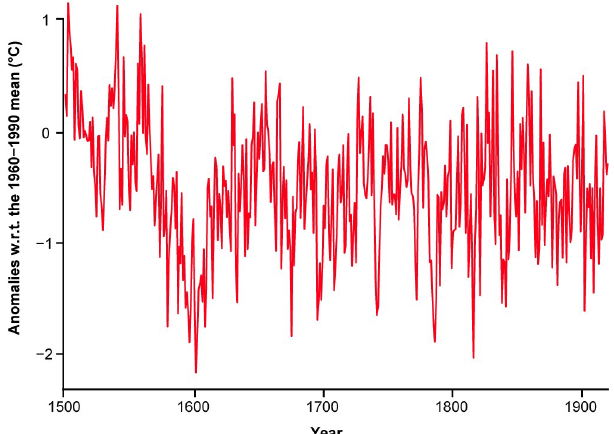
Figure 1. The 1500–1920 summer (JJA) temperature reconstruc- tion from Ljungqvist et al. (2019) based on a grid cell at 12.5 ◦ E and 57.5 ◦ N, roughly corresponding to Mark Municipality in south- ern Västra Götaland. Source: Ljungqvist et al.